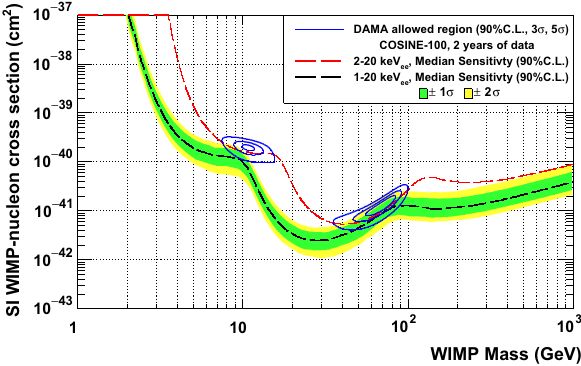
Fig. 25 Projected upper limits on the spin-independent WIMP- nucleon cross section using a likelihood analysis. The black curve rep- resents the median exclusion limit of COSINE-100 assuming a 1keV threshold at a 90%C.L. The green and yellow regions represent 1 σ and 2 σ deviations from this median, respectively. The blue contours designate DAMA-allowed regions for spin-independent interactions. A more conservative exclusion limit assuming a 2keV threshold for COSINE-100 is shown in